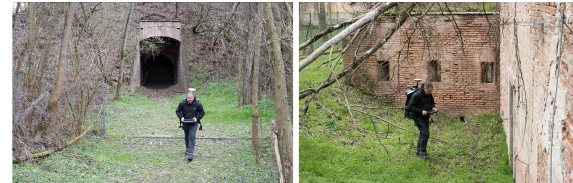
Figure 2. Leica personnel scanning the fort with the Pegasus Backpack.